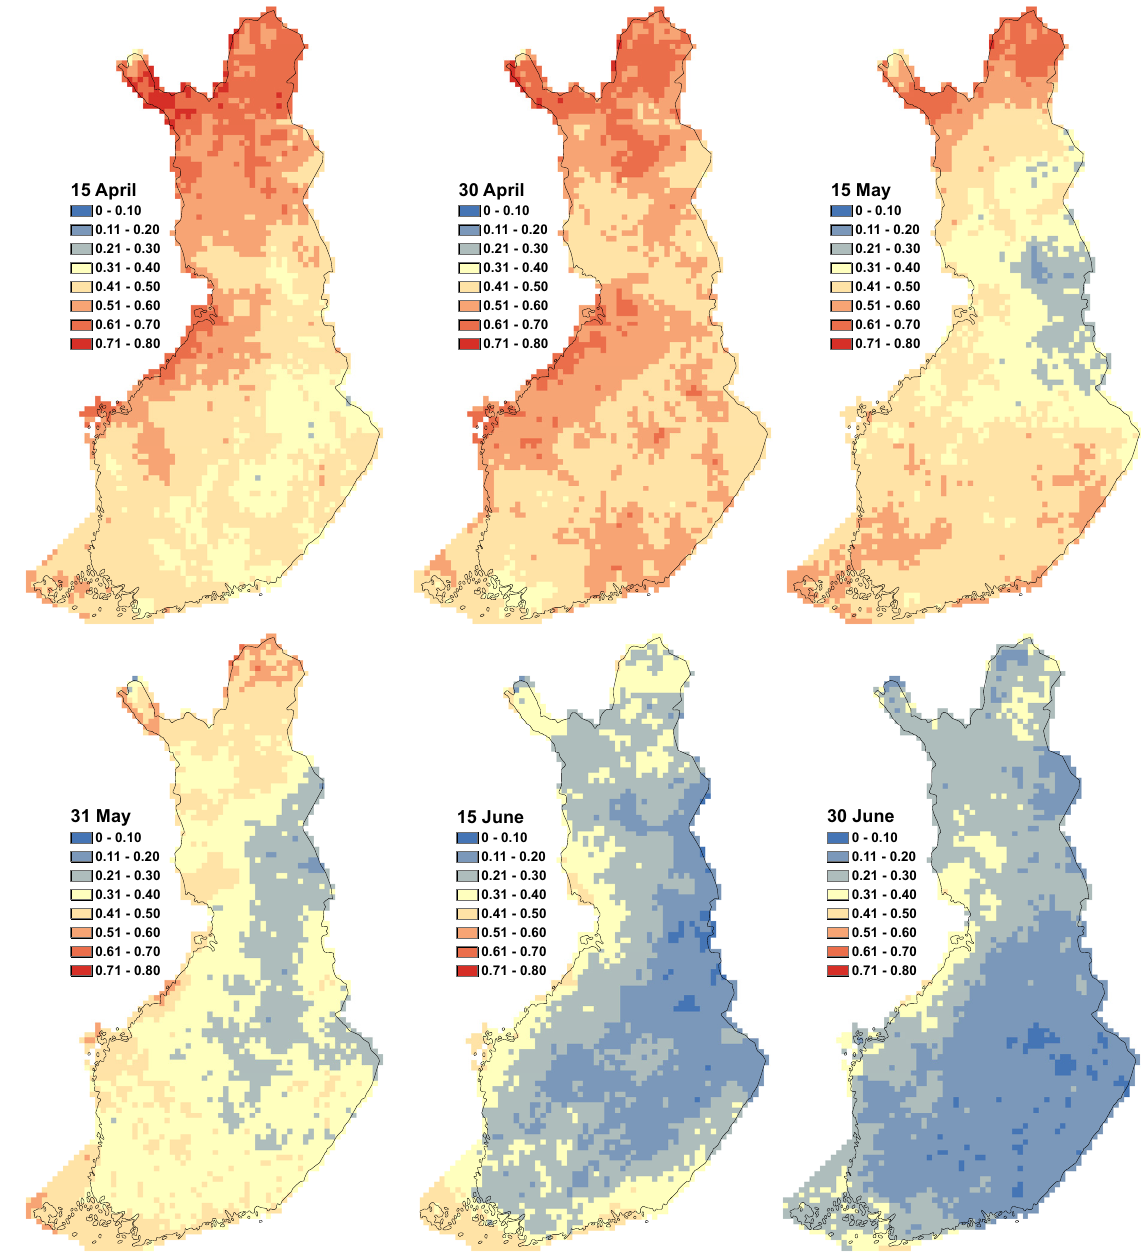
Fig. 1a. Probabilities of drought lasting for at least two weeks for the periods that ended on 15 April to 30